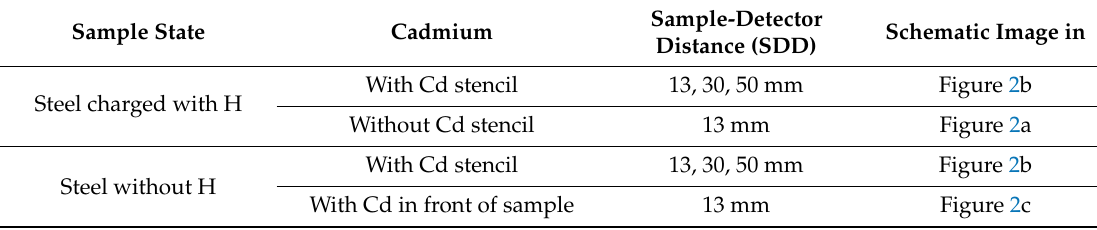
Table 1. List of neutron radiography experiments performed at the ANTARES